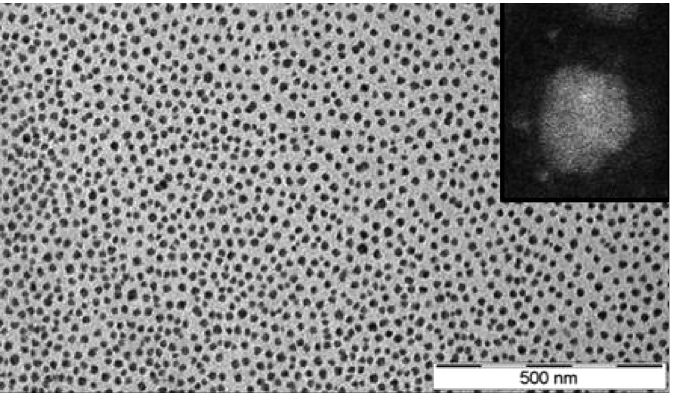
Figure 3. TEM images of the nanoscale ionic material (with inset showing a high-angle annular dark-field (HAADF) image of a single particle with a polymeric shell). Reprinted with permission from Fernandes et al.